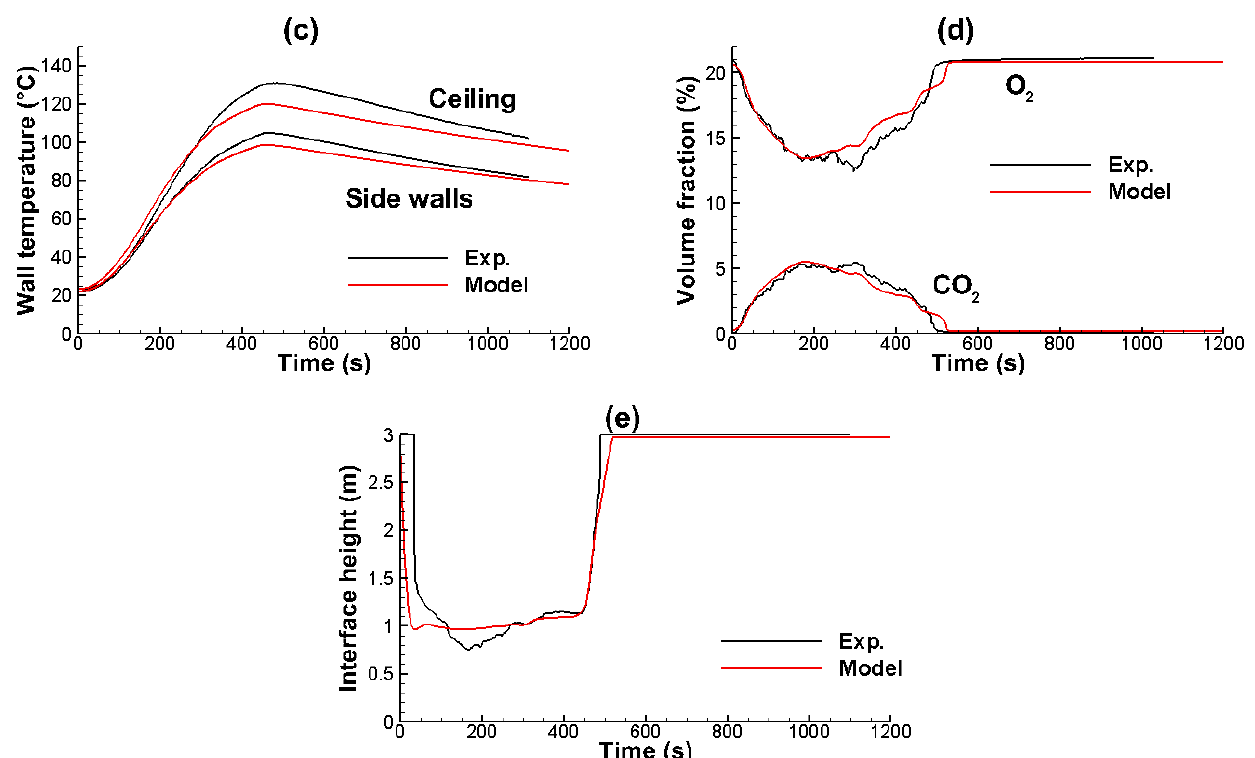
Figure 17. Test 9: ( a ) individual and total HRRs, ( b ) average gas temperature, ( c ) average wall temperatures, ( d ) volume fractions of O 2 and CO 2 in the exhausted gases, and ( e ) smoke layer interface height.